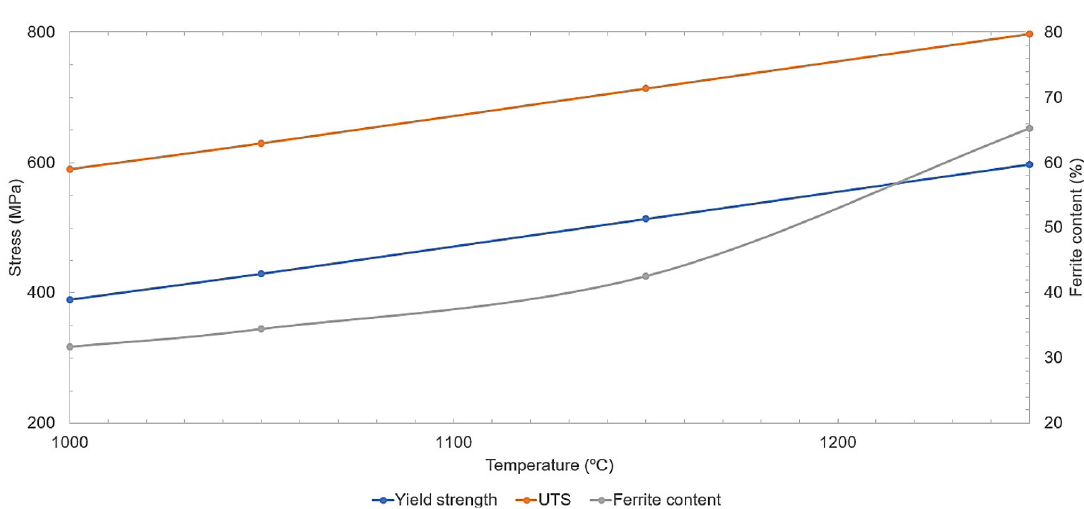
Figure 9. General results from 41 (apud 2 ). Relationship between the percentage of ferrite in the microstructure of duplex stainless-steel and its mechanical properties: ultimate tensile strength (UTS), yield strength and ferrite content (%). Figure adapted from 41 (apud 2 ).